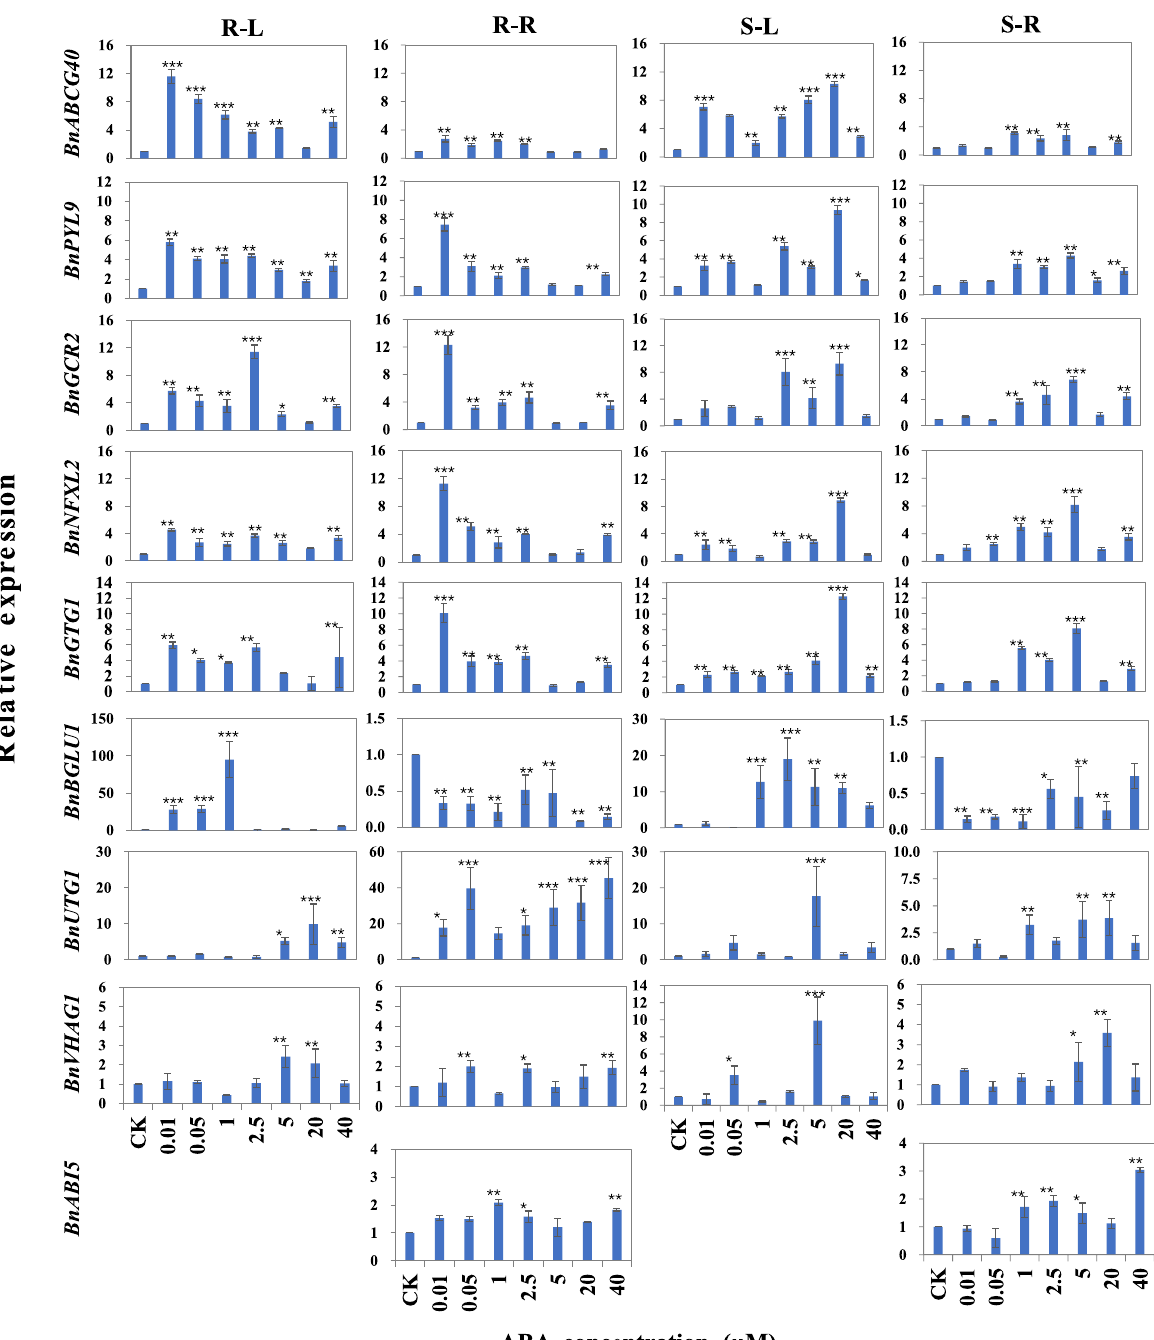
Figure 6. Relative expression of the genes ( BnABCG40 , BnNFXL2 , BnPYL9 , BnGCR2 , BnGTG1 , BnBGLU1 , BnUTG1 , BnVHAG1 and BnABI5 ) encoding ABA transport and response proteins of ramie under ABA treatment. S-L and S-R denote the expression in leaves and roots by spraying ABA on ramie plants, respectively. R-L and R-R denote the expression in leaves and roots by adding ABA directly to the culture solution, respectively. The 2 −ΔΔCt method was used to calculate the relative expression of the selected genes. Data are means ± SD of three biological replicates. Each replicate consisted of material from ten plants. *, ** and ***denote statistically significant differences from the control (CK, 0 μM) at P < 0.05, P < 0.01 and P < 0.001,